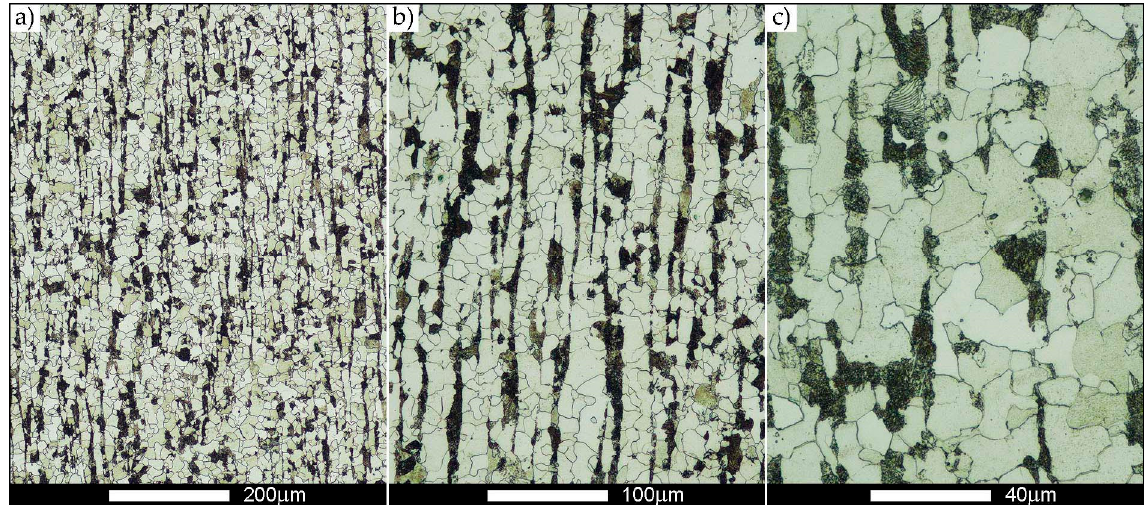
Figure 22. Welded joint microstructure of Hardox 450 in the delivery state (directly after welding) with revealed grain boundaries of prior austenite—BM zone shown in Figure 2. ( a ) 100×; ( b ) 200×; ( c ) 500×.